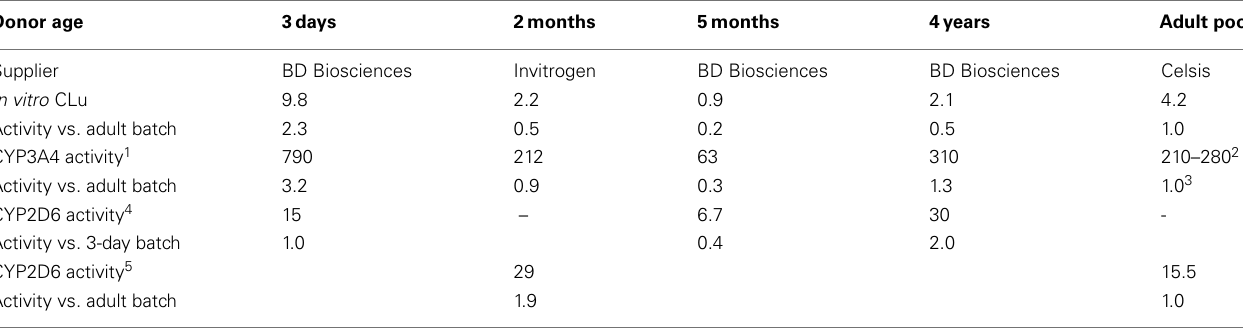
Table 2 | Experimentally measured in vitro clearance of oxycodone and reported CYP3A4 and CYP2D6 activities in hepatocyte batches used in the